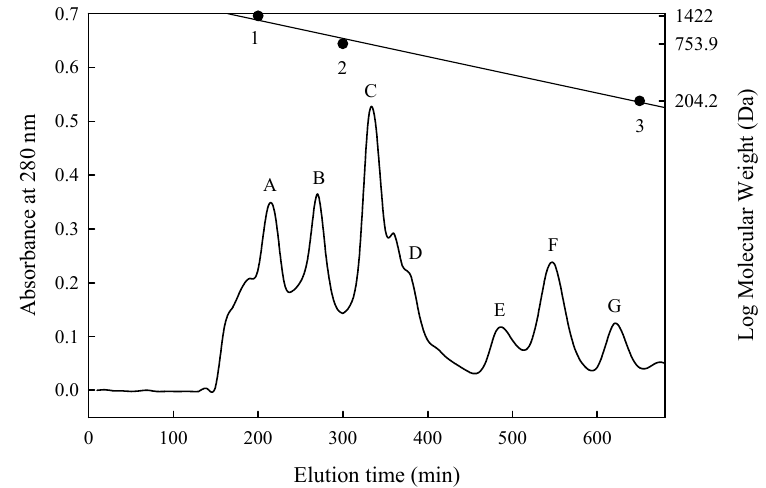
Figure 1. Sephadex G-15 column chromatography of peptides separated from PN-1 after digestion by gastrointestinal proteases. ● Standard materials: bacitracin (1422 Da); penta-L-phenylalanine (753.9 Da); and L-tryptophan (204.2 Da).